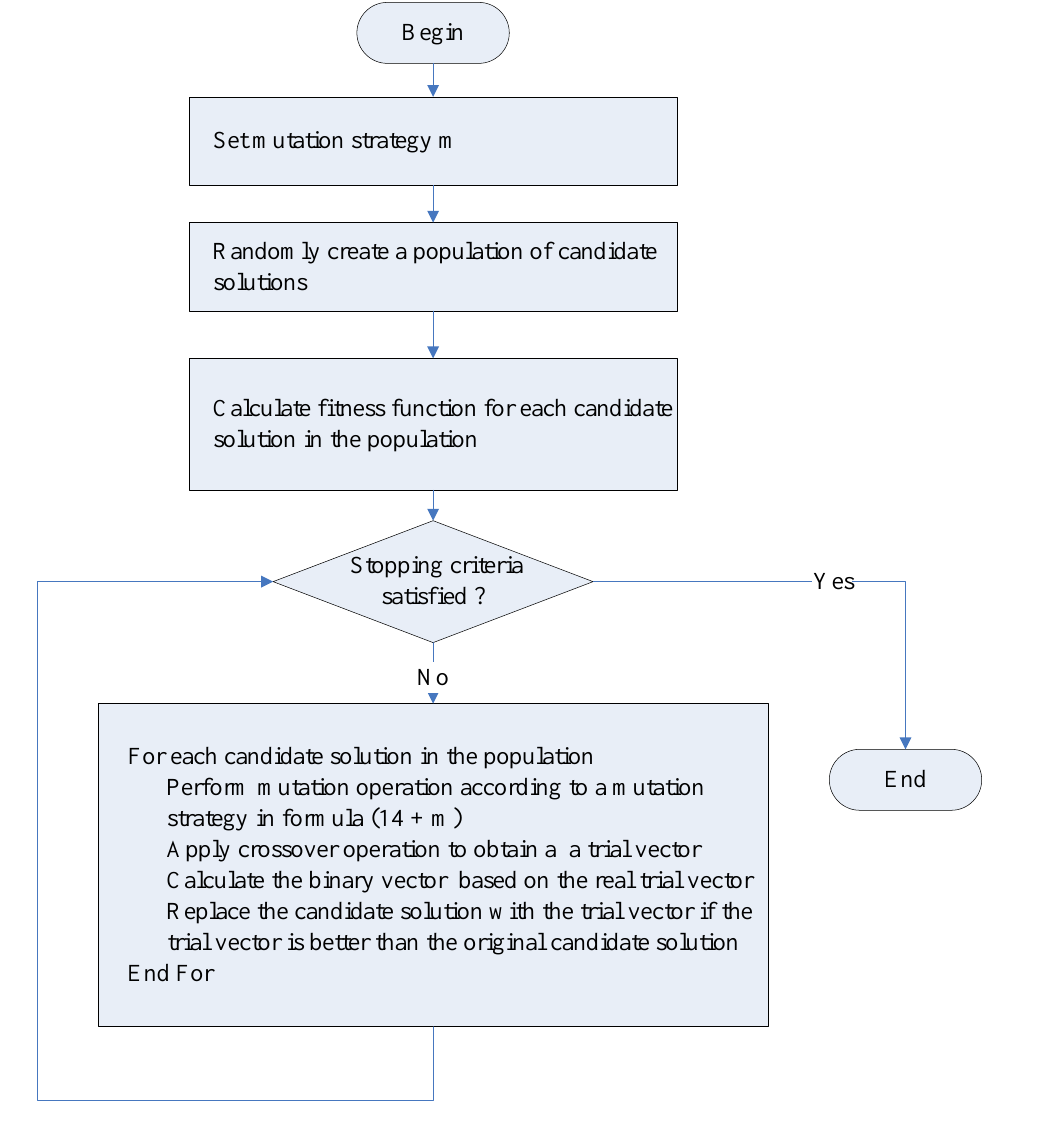
Figure 1. A flow chart for the DE- m algorithm with mutation strategy m .